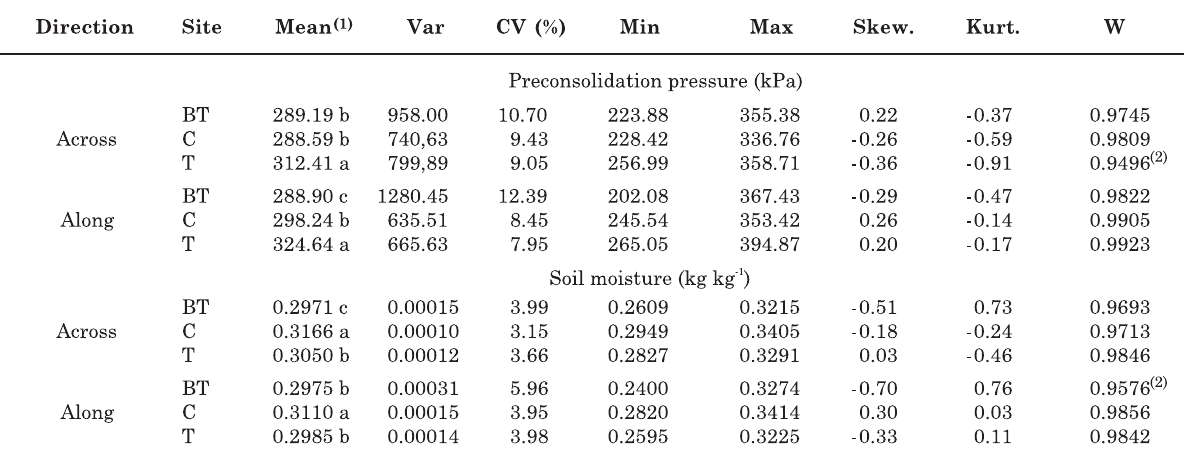
) and soil moisture values (200 m transects p